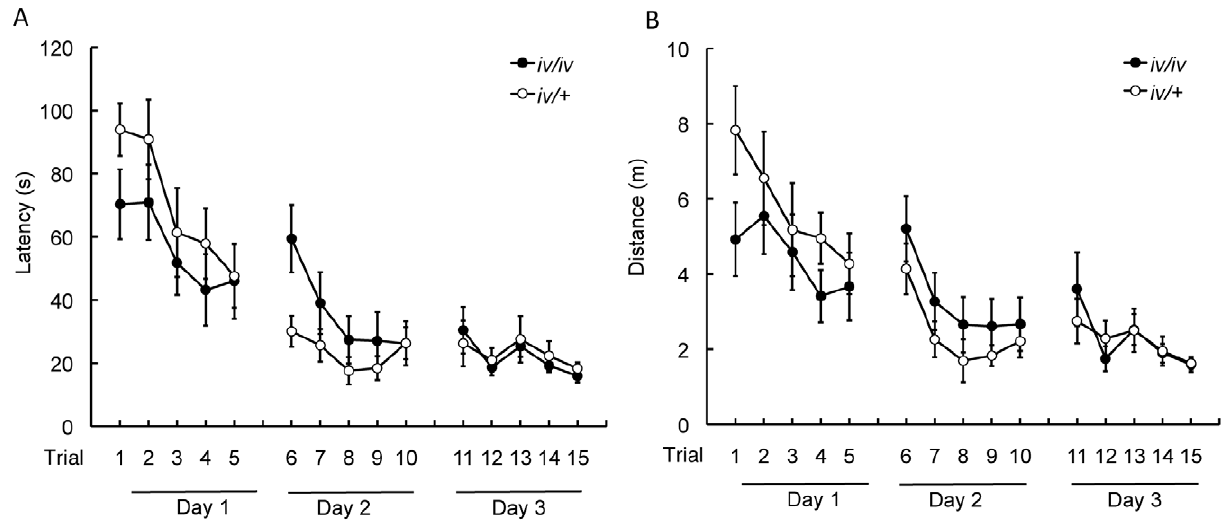
Figure 3. Acquisition of the dry maze. (A) Latency to reach the food-baited hole. Here and elsewhere in the legends, error bar shows the standard error of the mean. (B) Distance traveled to reach the food-baited hole.